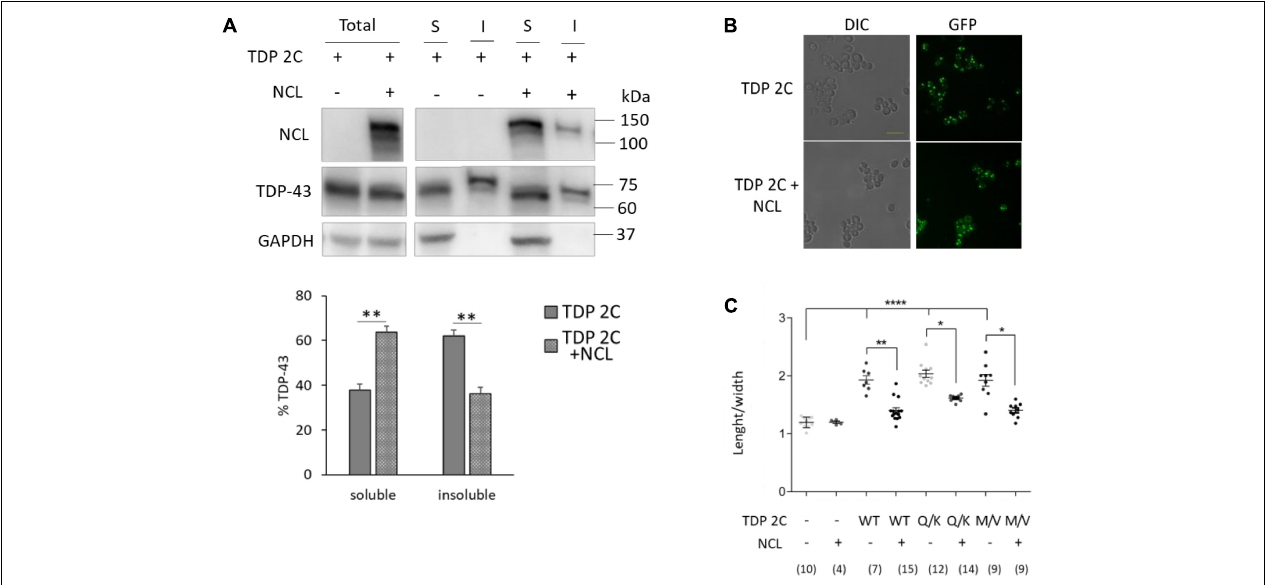
FIGURE 4 | NCL overexpression reduced the detergent-insoluble TDP-43 fraction and reversed the cell shape alteration caused by TDP-43 in yeast cells. (A) Yeast cells carrying two copies of TDP-43 transgene (TDP 2C), transformed with either empty vector (–), or a MC plasmid encoding NCL (+), were incubated 6 h in galactose-inducing medium, and subjected to biochemical separation of RIPA-soluble and -insoluble protein fractions. Total, soluble (S), and insoluble (I) fractions were analyzed by WB for the presence of NCL, TDP-43, or GAPDH (upper panel). The lower panel reports the densitometric analysis of TDP-43-immunoreactive bands in RIPA-soluble and -insoluble fractions. Data are reported as mean ± SEM, n = 5, ** p < 0.01, unpaired two-tailed Student’s t -test. Other details are as reported in the legend to Figure 1D . (B) The TDP 2C and the TDP 2C + NCL strains (as in A ) were incubated 6 h in inducing medium, and analyzed for cell morphology by DIC microscopy (left panel), and for TDP-43-GFP expression by epifluorescence (right panel). Shown images are representative of three biological replicates for each strain. Scale bar , 10 µ m. (C) Cell morphometry (as in the legend to Figure 2B ) of yeast strains carrying two copies of either WT, or mutant (Q331K, M337V) TDP-43 transgene, transformed with either empty vector (–) or the MC plasmid coding for NCL (+). * p < 0.05, ** p < 0.01, **** p < 0.0001, Kruskal–Wallis test followed by a Dunn’s post hoc test (n for each condition being indicated in the bottom part of the